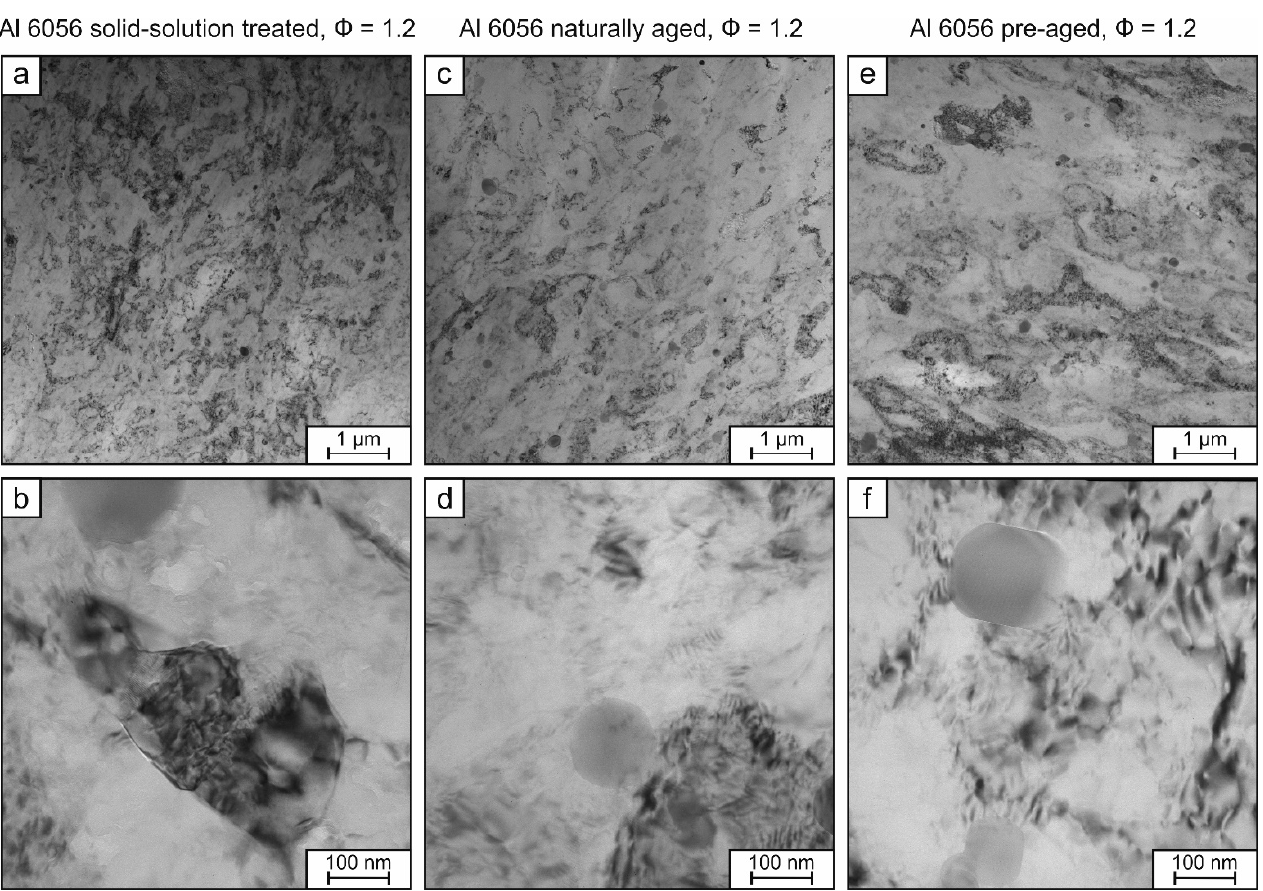
Figure 6. TEM micrographs of the 6056 aluminum alloy in ( a , b ) solid-solution treated, ( c , d ) naturally-aged and ( e , f ) pre- aged condition after linear extrusion with an induced strain of φ = 1.2 and subsequent artificial aging at 120 °C for 10 min. Regardless of the initial heat treatment, all conditions exhibit a high dislocation density along with the beginning arrangement in dislocation cells.